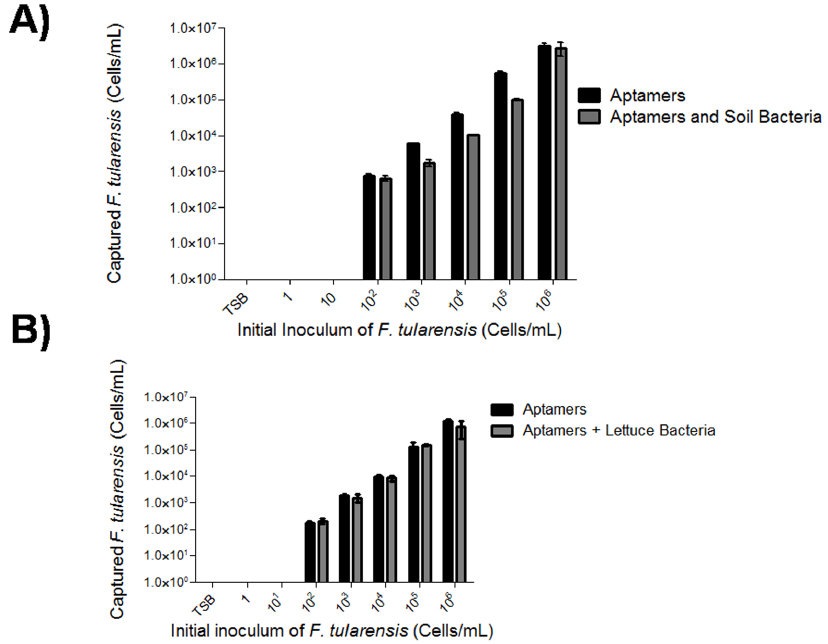
Fig. 3. DNA aptamers against F. tularensis specifically capture F. tularensis in mixed bacteria samples. A biotinylated aptamer cocktail composed of 10 aptamers (0.4 pmol each) was bound to M-280